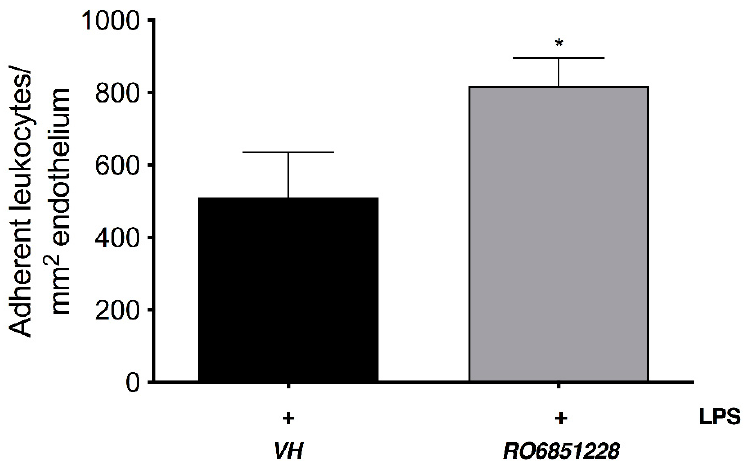
Figure 3. The CB 2 R inverse agonist, RO6851228 increases leukocyte adhesion in the iridial microcirculation during EIU. Bar graph represents the mean number of adherent leukocytes at 6 h post-intravitreal injection of LPS and following topical treatment with either vehicle (Tocrisolve, n = 8) or RO6871228 (1.5% w / v ; n = 6). Data are presented as mean ± SD. Two-tailed unpaired t-test; * p < 0.05 compared to LPS +